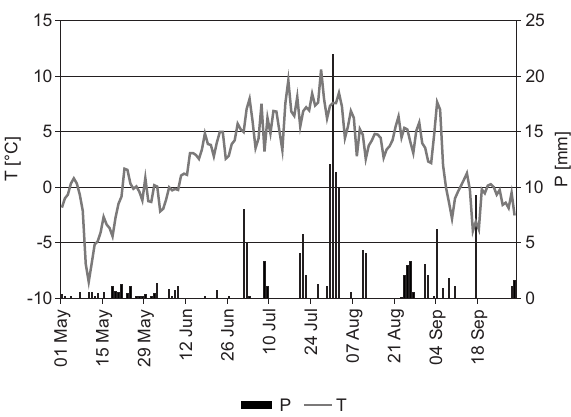
Fig. 2. Air temperature (T) and precipitation (P) from May to September 2004; meteorological station at Ny-Ålesund (Spitsbergen), data from Norwegian Meteorological Insti- tute,